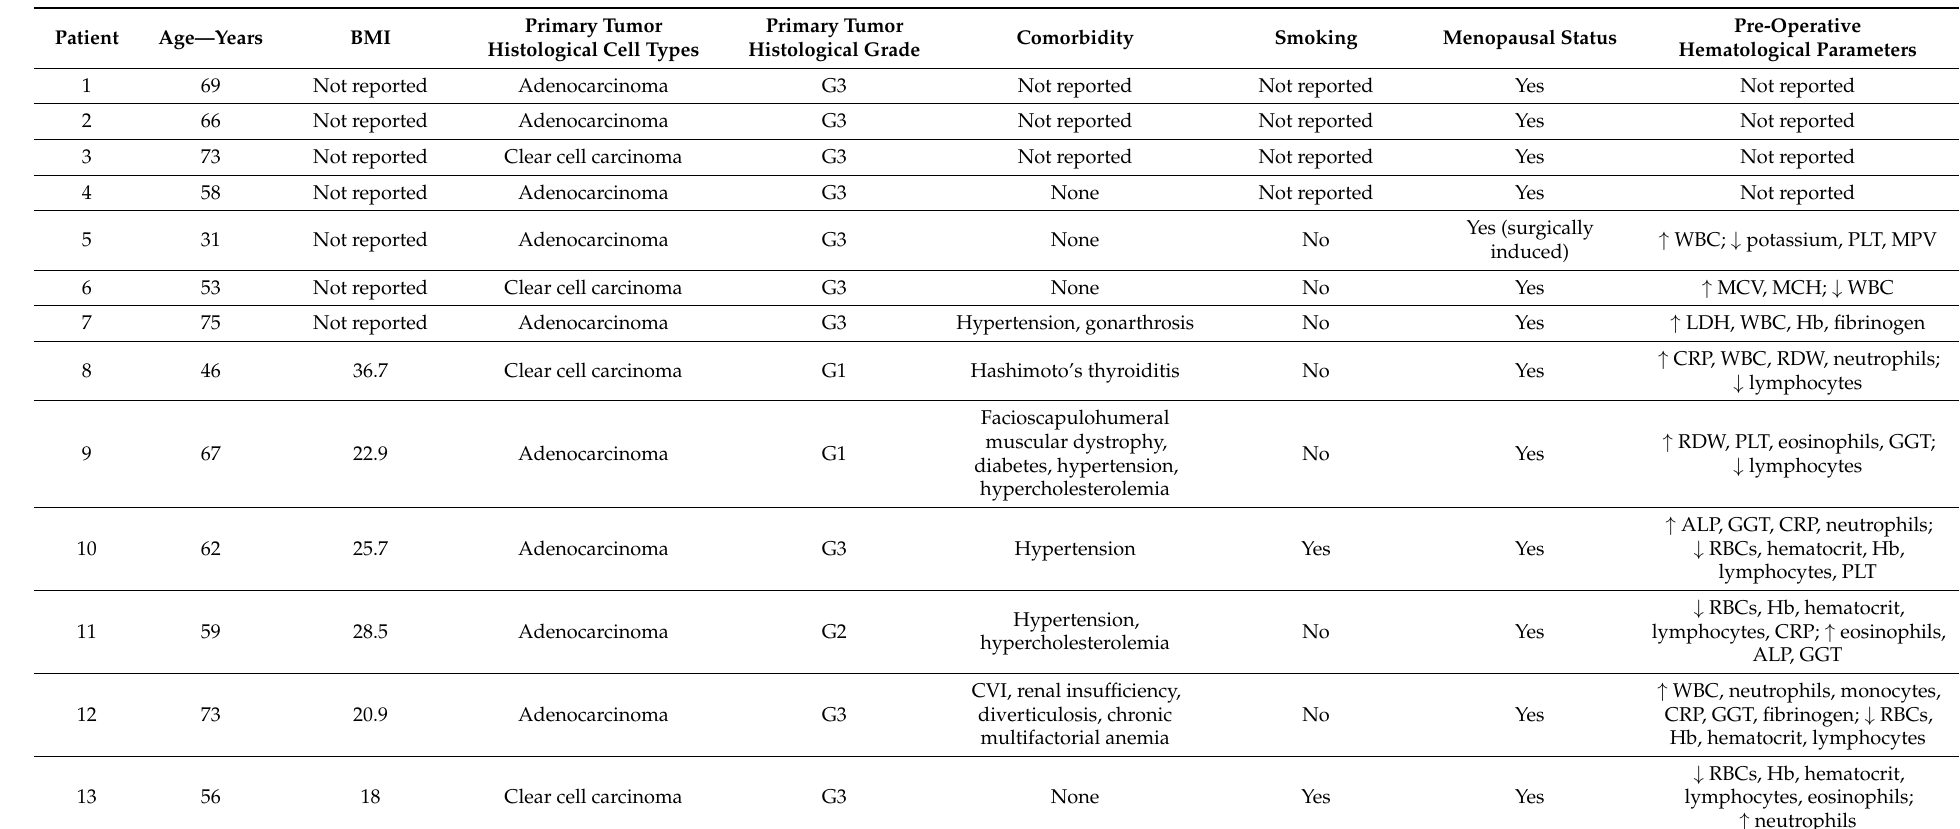
Table 1. Patients’ characteristics and pathological